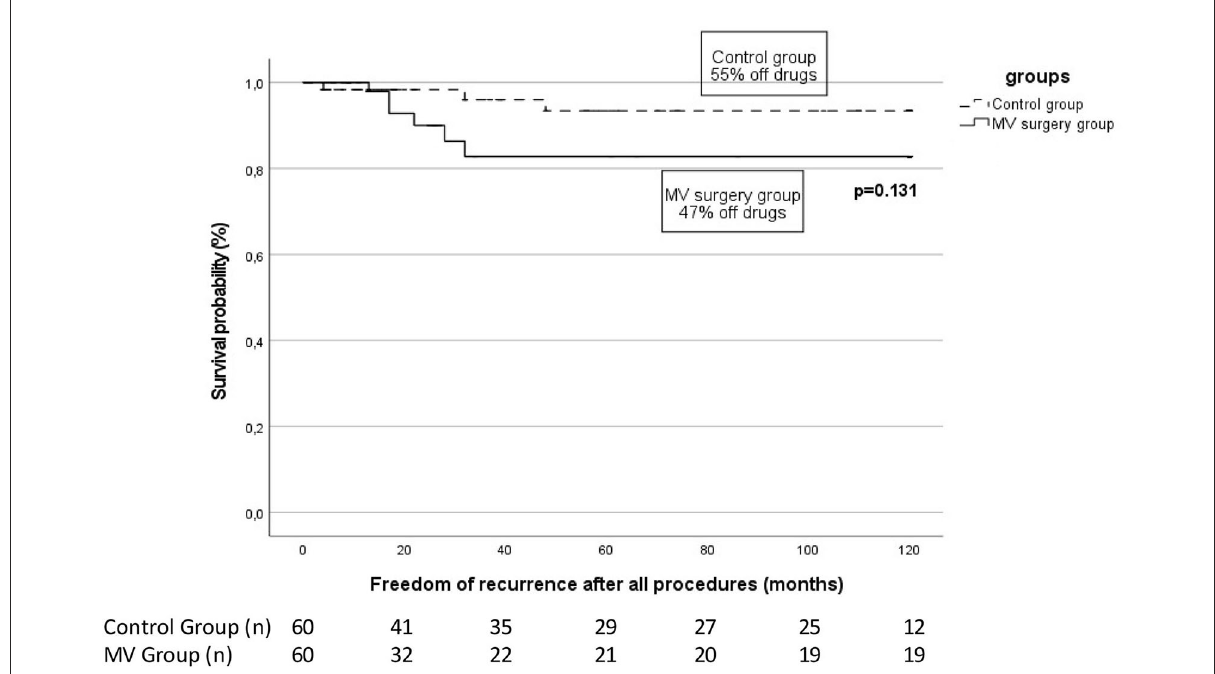
FIGURE2 Arrhythmia-free survival in patients with previous mitral valve (MV) surgery patients vs. control at the end of follow-up after a median of 2 (2–2) catheter ablation. The proportion of patients off antiarrhythmic drugs is specified for each group. The number of patients at risk at each time interval is shown below the figure. The p -value reflects the Log-rank significance at the end of the